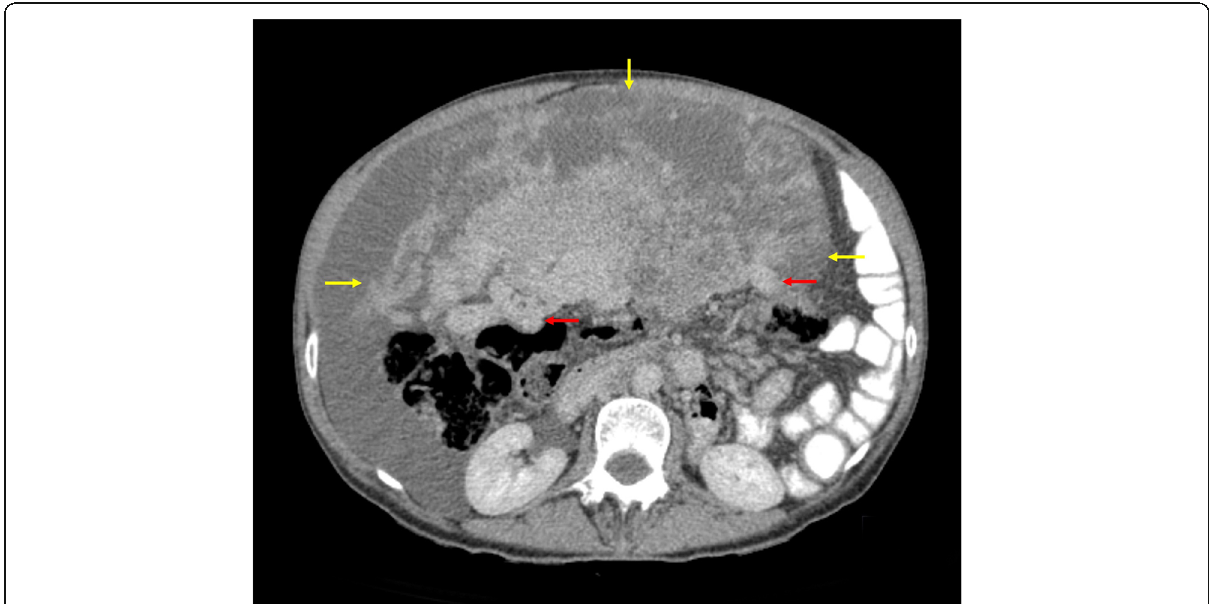
Fig. 3 Axial post-contrast MDCT image at the level of the left kidney lower pole. The previous enlarged vessels behind the tumour (yellow arrows) are also seen (red arrows). The jejunum is compressed laterally